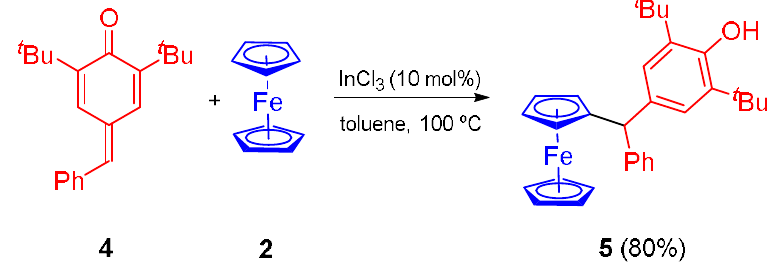
Table 1. InCl 3 -catalyzed reaction of p -hydroxybenzyl alcohols 1 and ferrocene ( 2 ). Entry Entry Substrate R